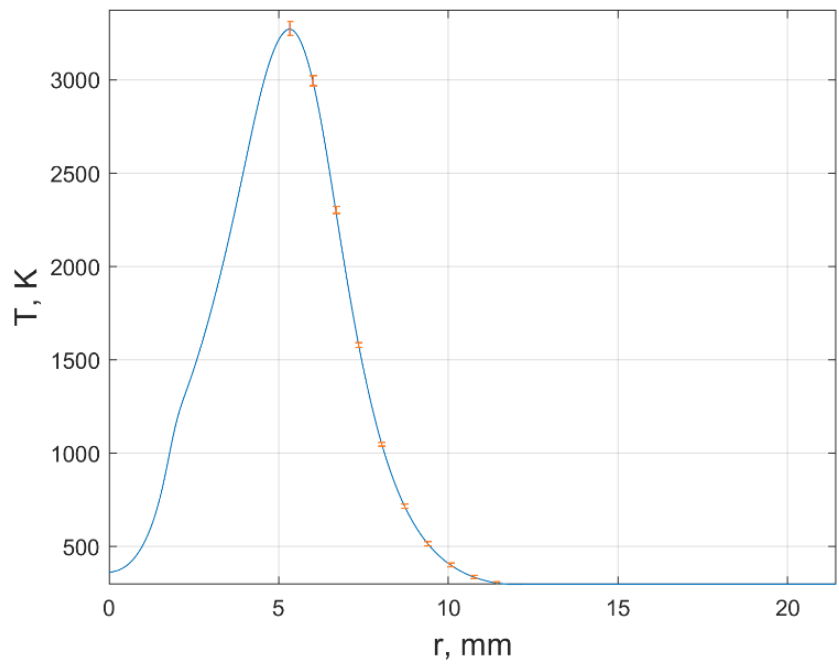
Figure 6. The estimates of the temperature error in of the flame cross section y = 6 mm.